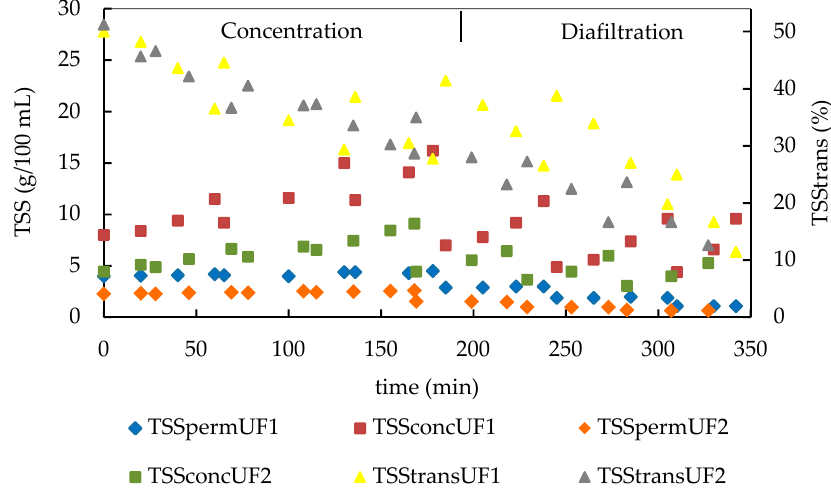
Figure 3. Distribution of total soluble substances (TSSs) in the permeate and concentrate streams and transference of TSSs through the membrane of both replicates (UF 1 and UF 2 ) of the studied GSE during UF and diafiltration by a 10-kDa MMCO membrane.